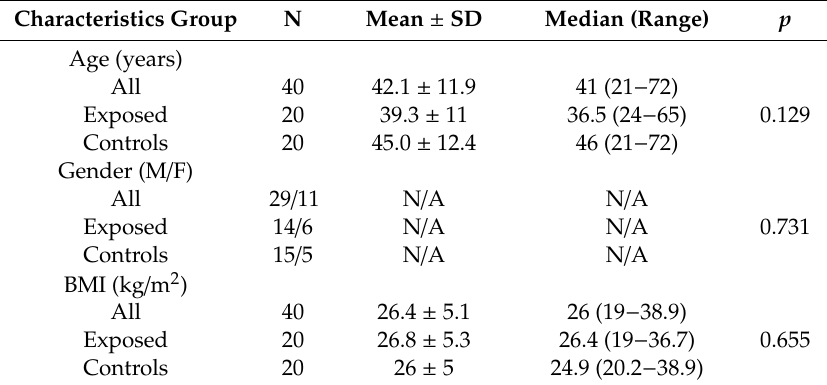
Table 4. General characteristics of the exposed and control subjects.